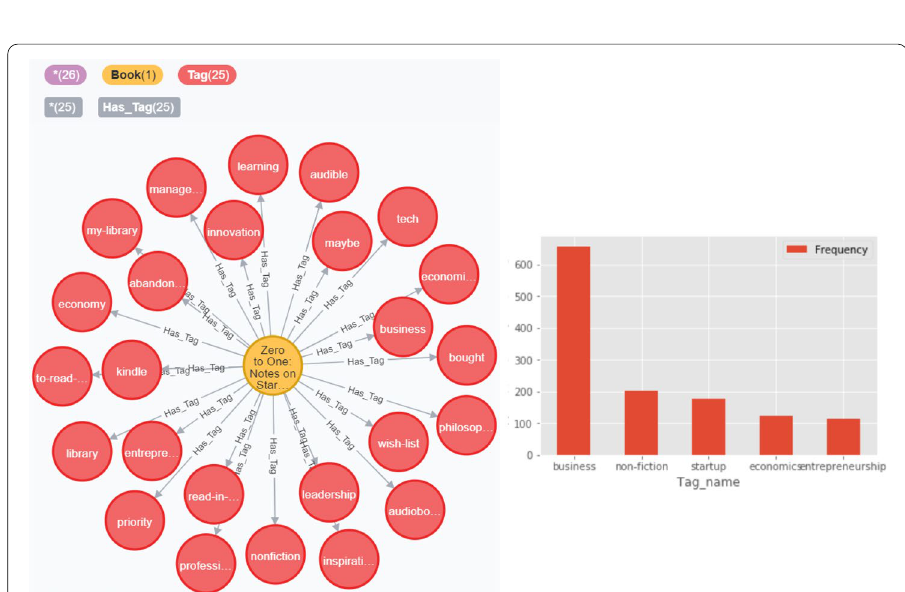
Fig. 7 Cypher Query (1)-KG: tags and their Frequency describing the book “Zero to One: Notes on Startups, or How to Build the